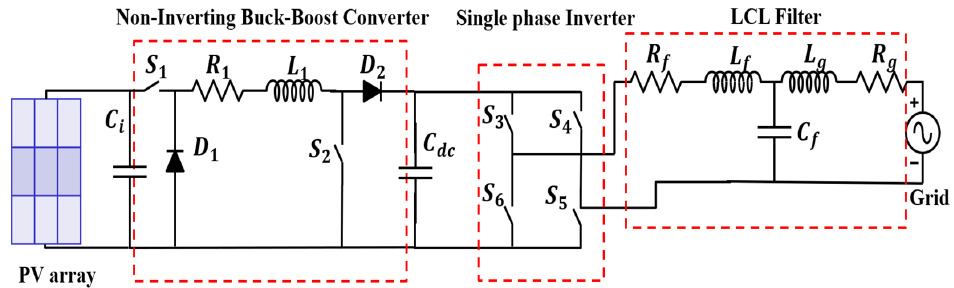
Figure 1. PV single-phase grid-connected system.